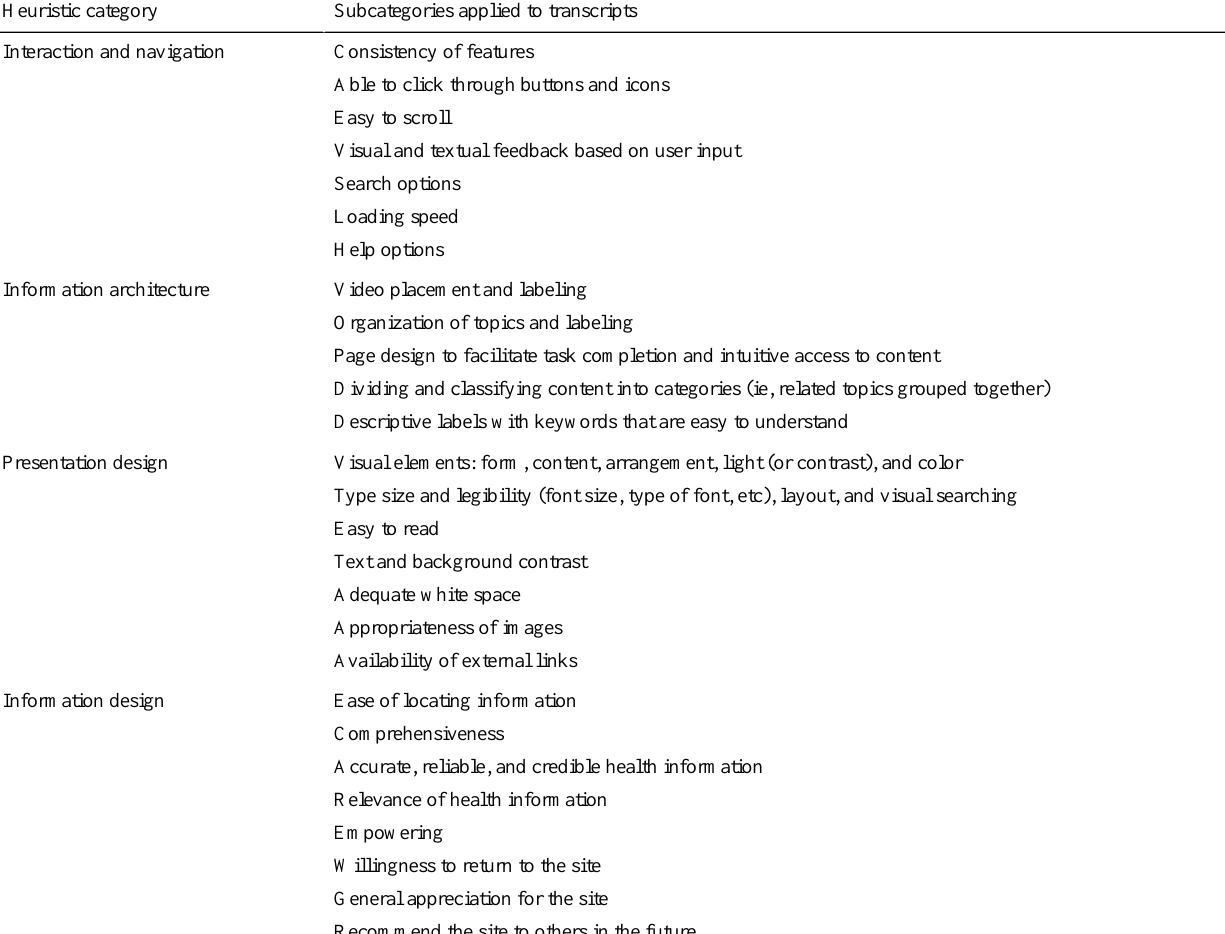
Table 2. Subcategories referenced to derive top-down codes applied to qualitative